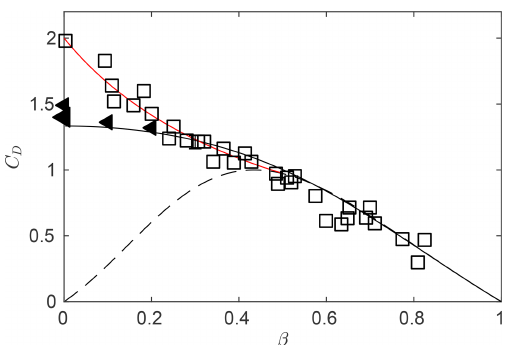
Figure 2. Porous plate drag coefficient versus plate open area ratio, β = A p /A , where A p is the porous plate area and A is the gross plate area. Squares: measurements with no splitter plate. Triangles: measurements with splitter plate. Solid line: analytical prediction of Steiros and Hultmark (2018). Dashed line: analytical prediction of Rankine–Froude theory. Red line: Glauert’s empirical correction. Adapted from Steiros and Hultmark